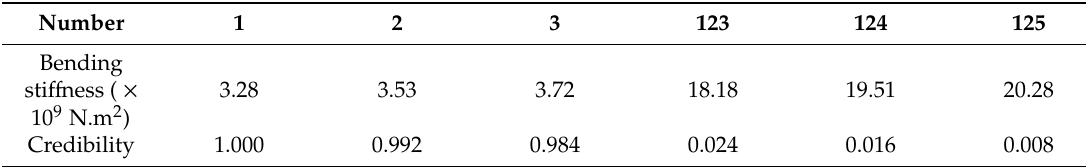
Table 5. Probable values of bending sti ff ness and